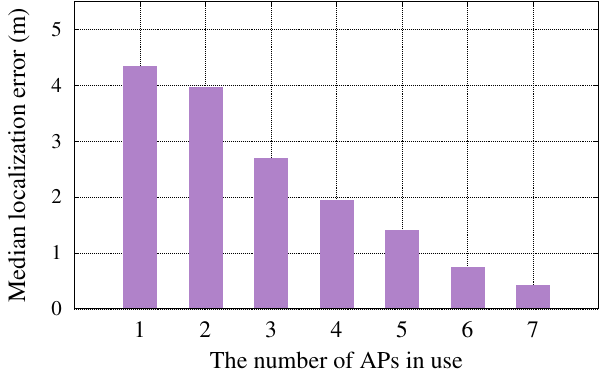
Figure 12. Effect of changing the number of access points on RRLoc performance.